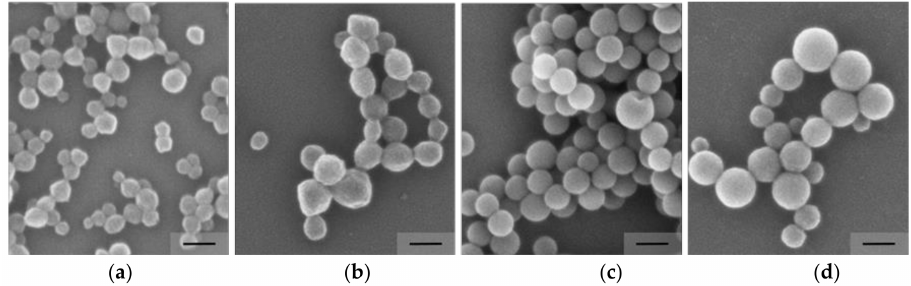
Figure 3. SEM images of ( a ) PMMA- co -AUPDS; ( b ) PMMA- co -EGDMA- co -AUPDS; ( c ) PS- co -AUPDS and ( d ) PS- co -DVB- co -AUPDS. The particles were formulated using 2 mol% AUPDS surfmer. The amount of cross-linker for ( b , d ) was 10 mol%. All scale bars represent 100